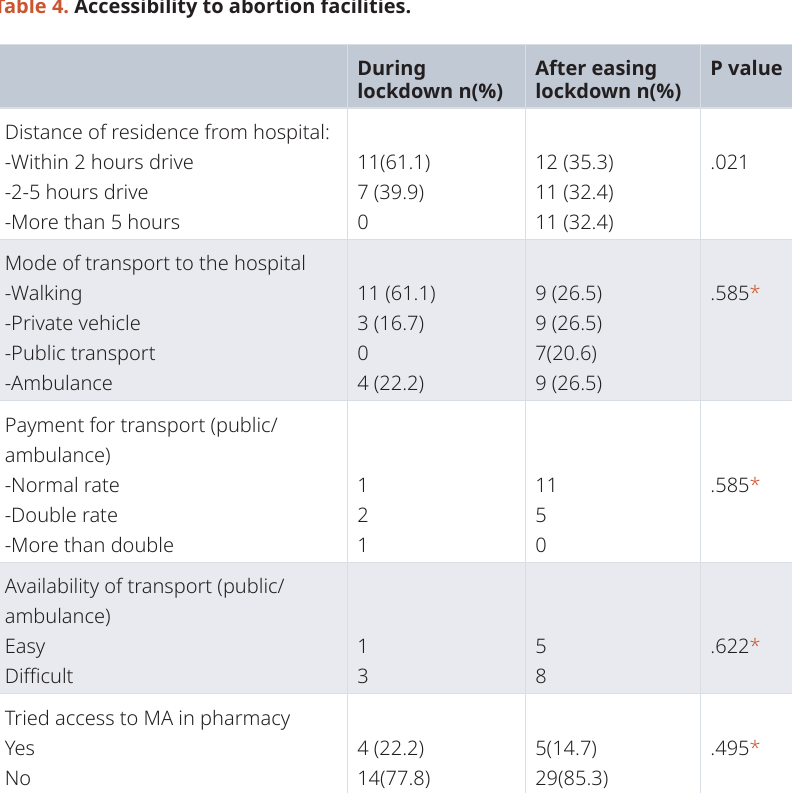
Table 4. Accessibility to abortion